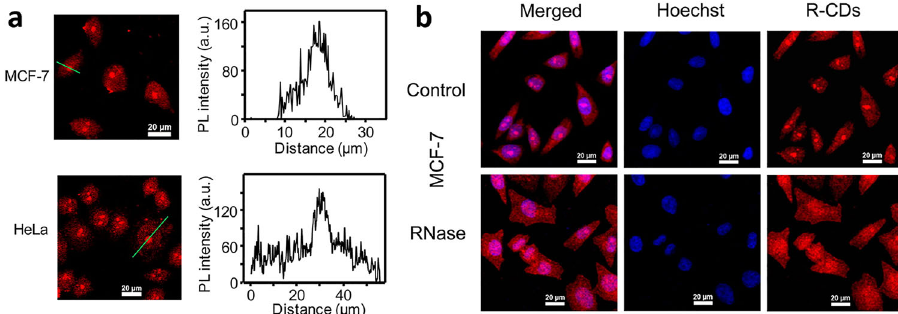
Fig. 2 The nucleolus-speci fi c labeling capability of RTCDs. Two-photon confocal fl uorescent images of cells incubated with RTCDs a living MCF-7 cells and HeLa cells, along with corresponding quantitative fi gure along the green line ( λ ex = 850 nm fs-pulse laser, λ em = 600 – 750 nm; scale bar = 20 μ m). b Confocal fl uorescent images of the RTCDs and Hoechst without (i.e., control) and with the RNase treatment of MCF-7 cells (Hoechst, λ ex = 405 nm, λ = 420 – 500 nm; RTCDs, λ = 543 nm, λ = 550 – 750nm; scale bar = 20 μ m). (Fig. 2a, b adapted with permission from ref. 51 , Copyright 2016 em ex em American Chemical